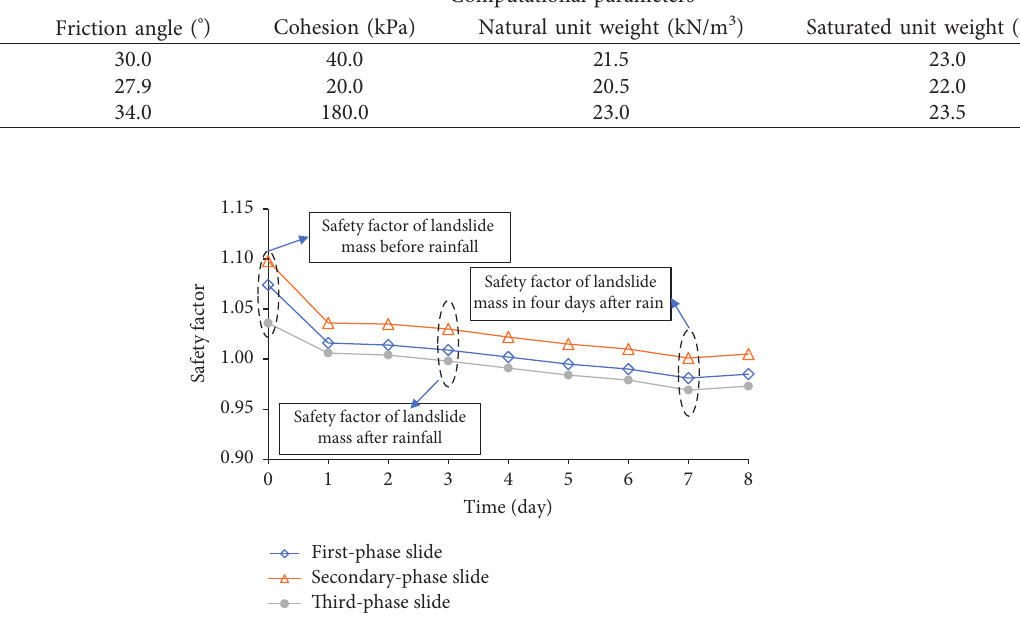
Figure 10: Changes of safety factor of profile A-A’ in zone I with time under rainfall